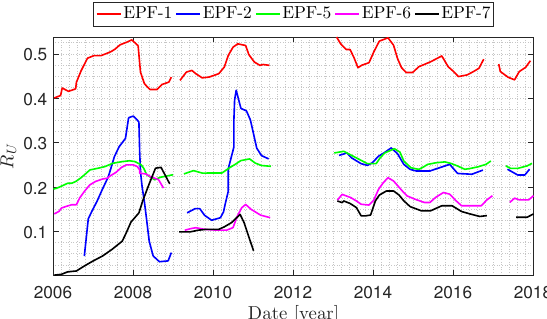
Figure 8. Variation of R U in Section